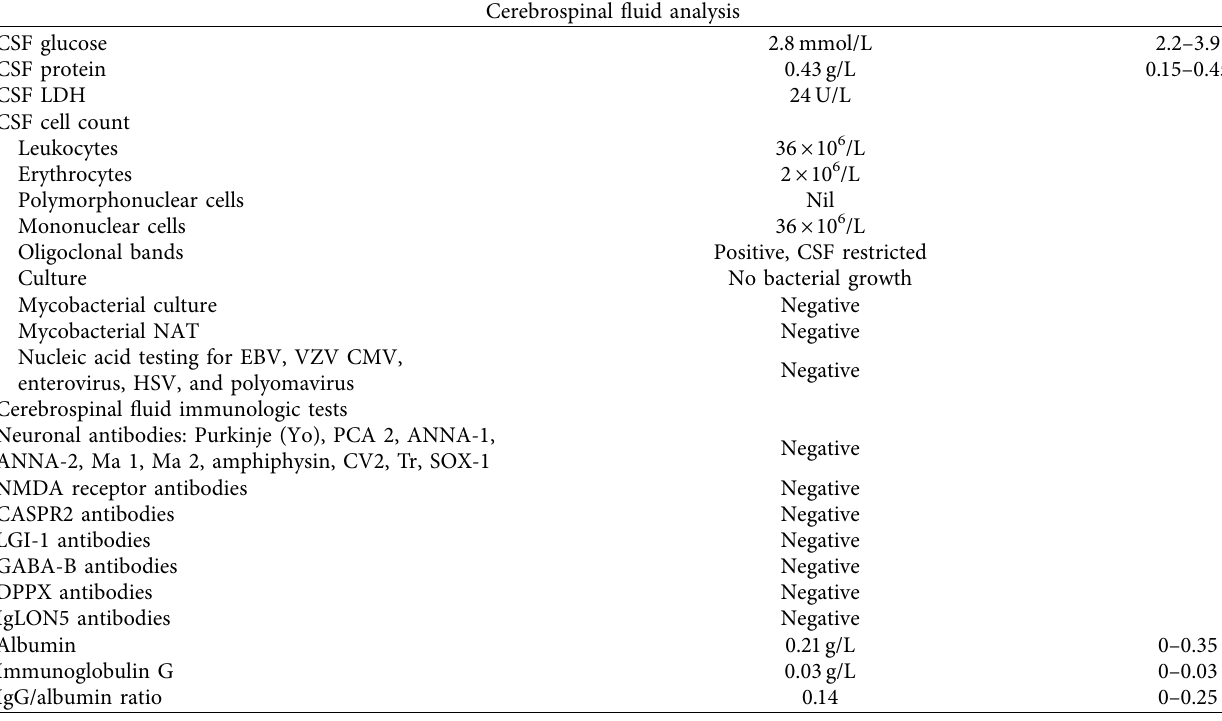
Table 1: CSF studies.